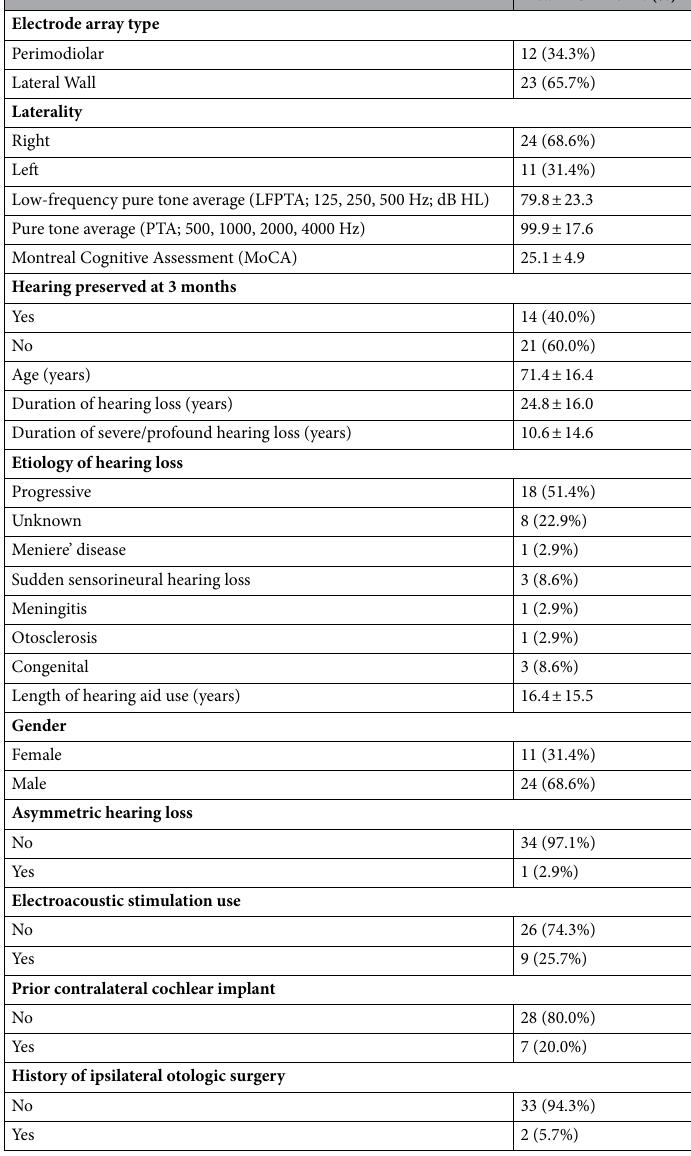
Table 1. Demographic information for all 35 patients who met inclusion criteria for the study and underwent cochlear implantation with 3-month follow-up for intracochlear electrocochleography